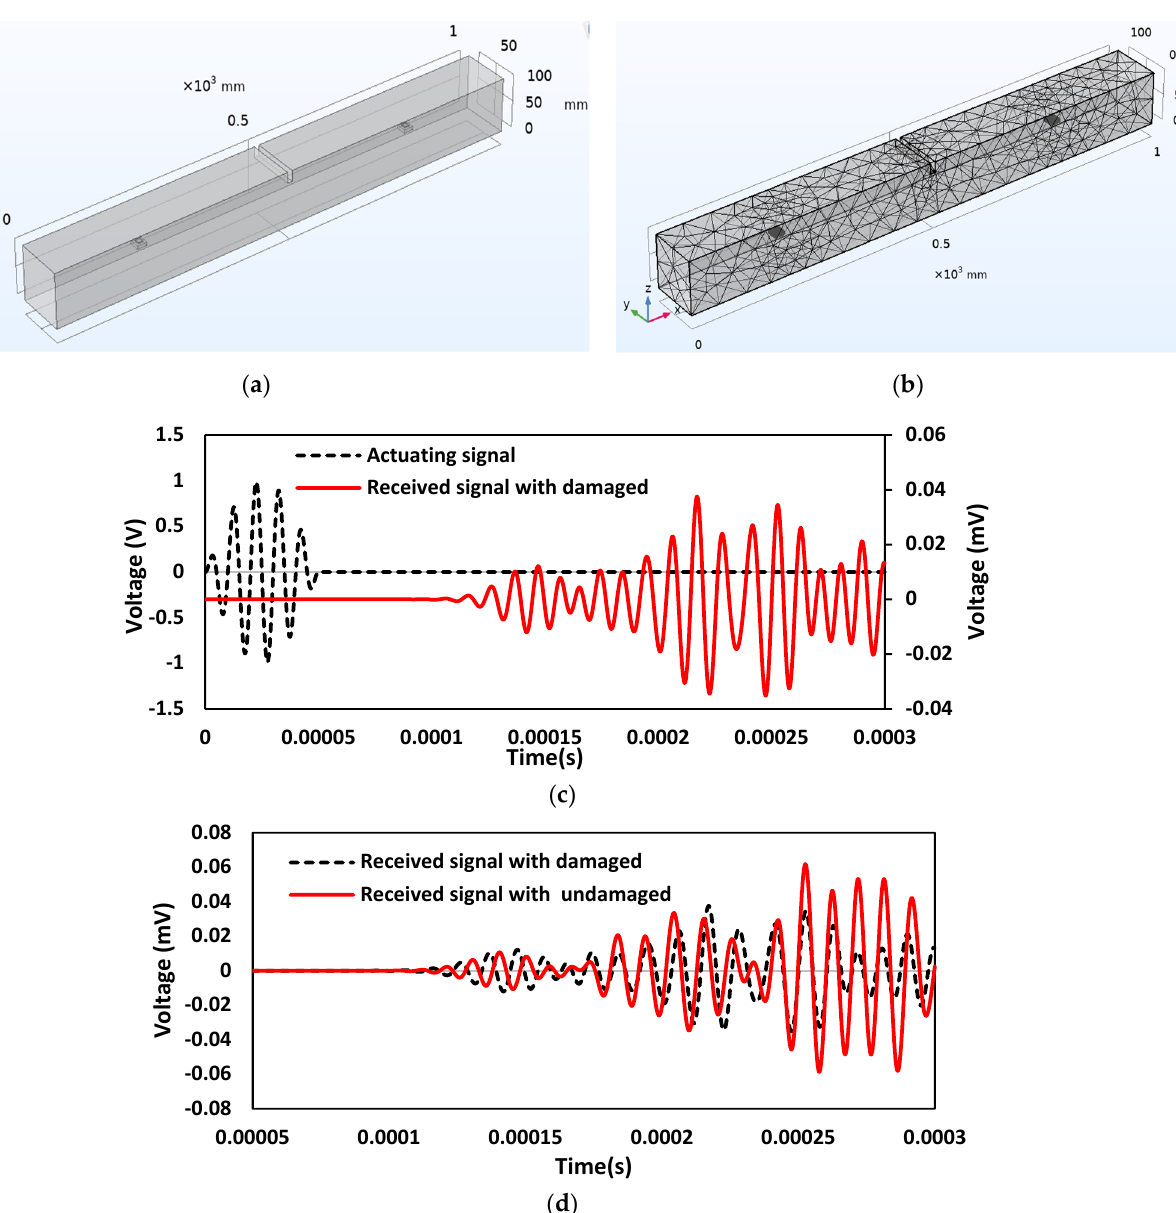
Figure 17. Concrete beam with embedded SSU: ( a ) Schematic 3-D model; ( b ) Response spectrum obtained from wave propagation measurements in the actuator–receiver mode.